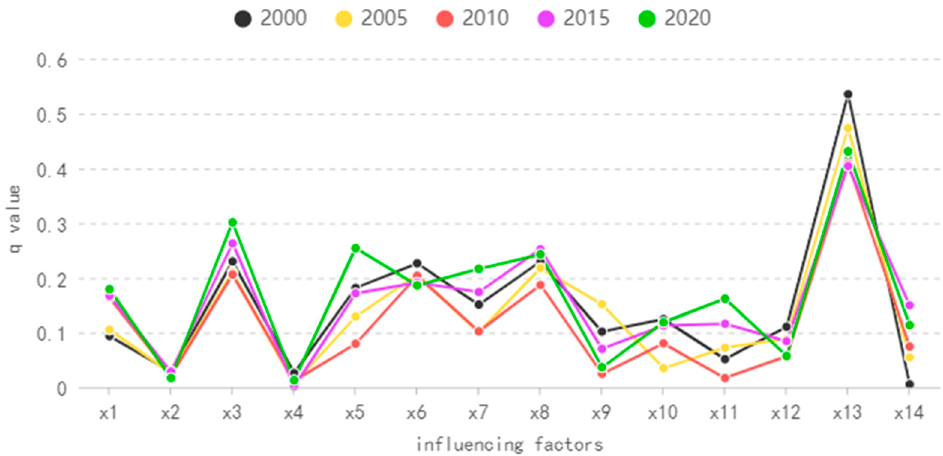
Figure 4. Q value results of each year.